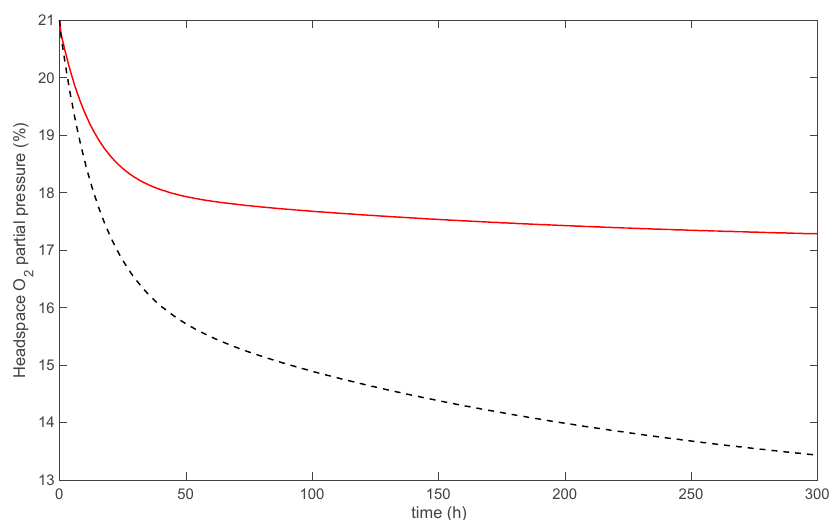
Figure 9. Simulated headspace O 2 partial pressure: actual case, i.e., with oxidation during extrusion (red line), and theoretical case, i.e., with no oxidation during extrusion (black dashed line).